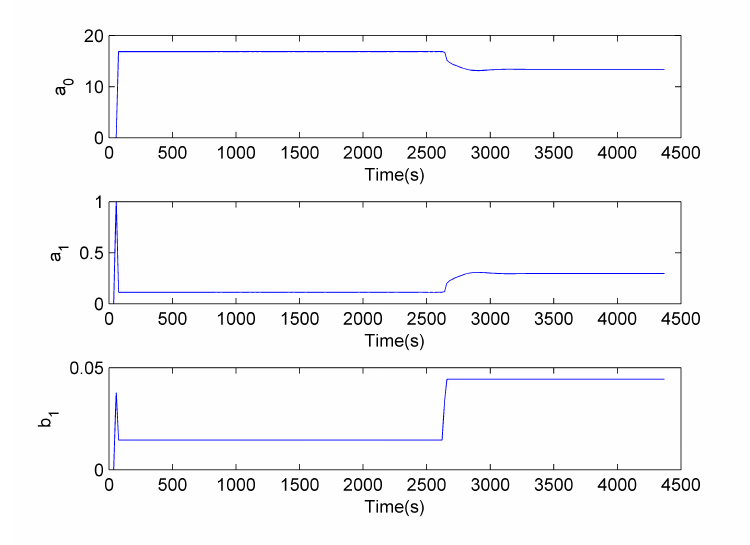
Figure 8. Simulation result of the proposed method.